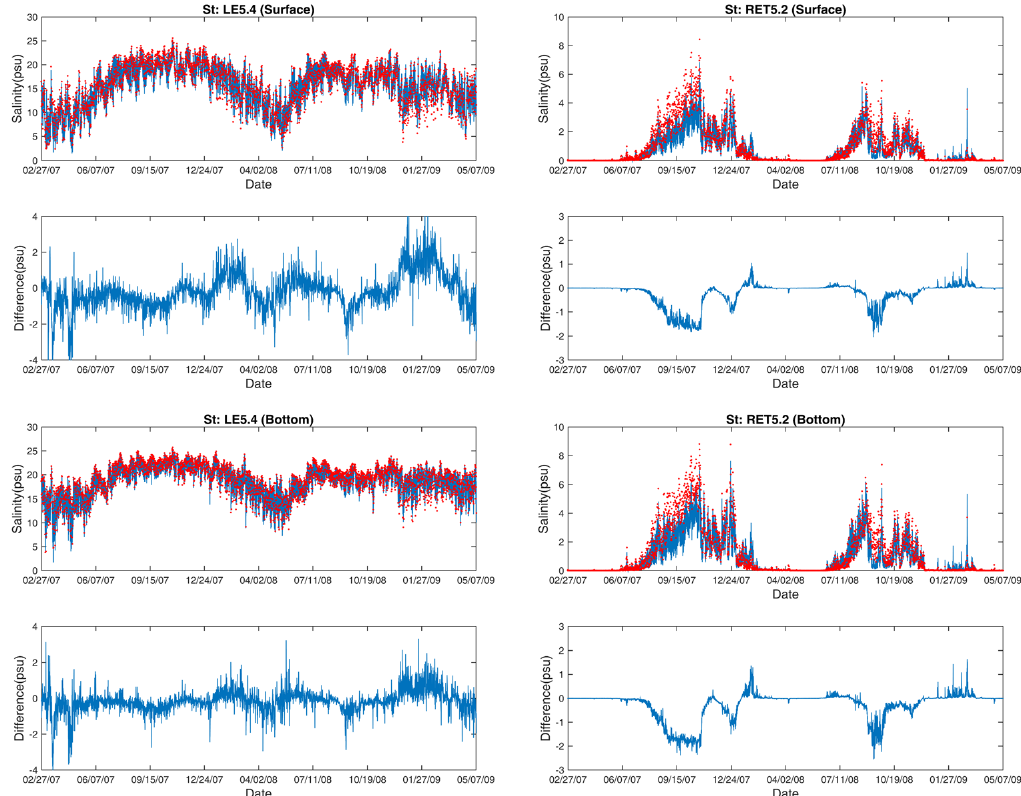
Figure 9. Sensitivity tests for flow at Stations RET5.2 and LE5.4 (red lines show the results of a model simulation using watershed flow, and blue lines show results of a simulation using USGS flow at three upstream stations; the difference shows the difference of runs between USGS flow and watershed flow).